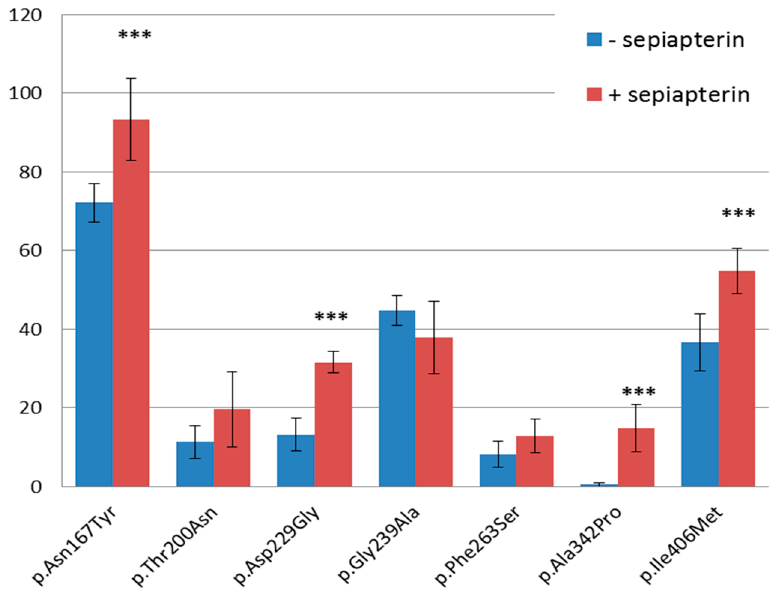
Figure 2: Mutant PAH protein levels compared to WT PAH expressed in HepG2 cells in the presence and absence of BH-4 precursor sepiapterin. The results were calculated as a mean of three independent Western blot analyses performed from three independent PAH expressions in HepG2 cells. *** statistically significant level changes with the p- value < 0.0001 between mutated proteins expressed in the presence and absence of sepiapterin.